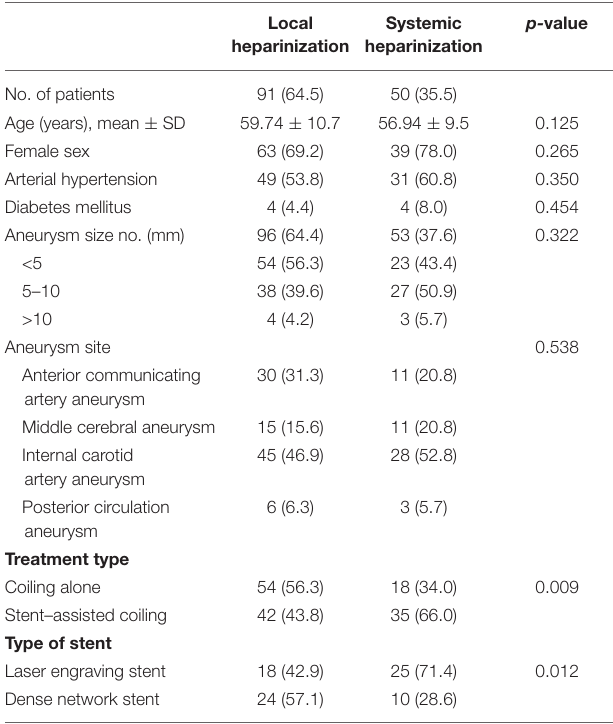
TABLE 1 | Demographic parameters and distribution of patients who received local and systemic heparinization treatment for aneurysms.